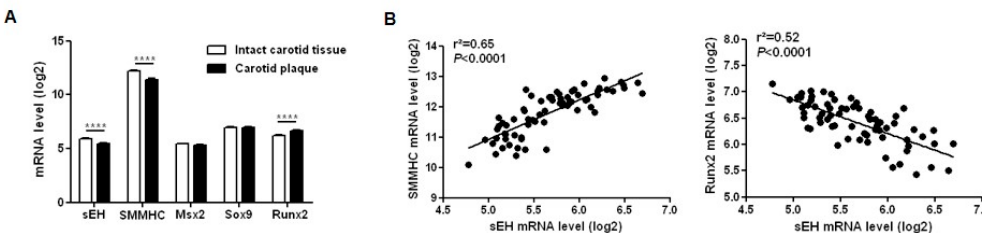
Figure 6. ( A ) mRNA expression levels of soluble epoxide hydrolase (sEH); of the contractile marker smooth muscle myosin heavy chain (SMMHC); and of the osteochondrogenic markers Msh homeobox 2 (Msx2), sex-determining region Y-box 9 (Sox9) and runt-related transcription factor 2 (Runx2) in calcified carotid plaques ( n = 34) and distant intact tissues ( n = 34). ( B ) relationships between sEH and SMMHC or Runx2 mRNA levels. **** p < 0.0001.